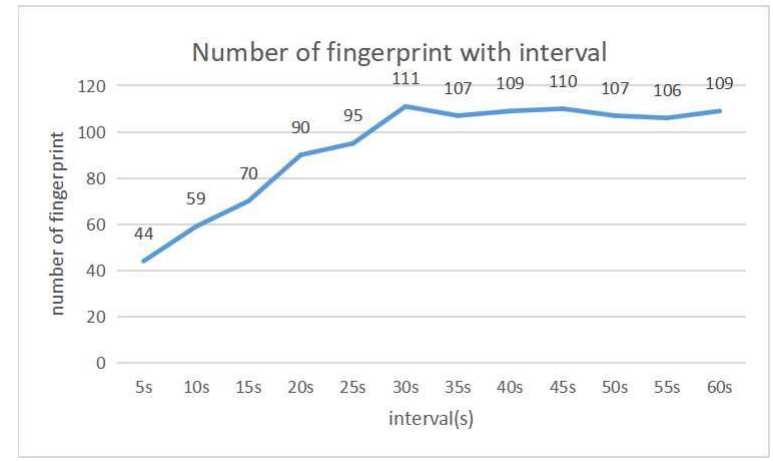
Figure 5. Number of fingerprints with interval variation.